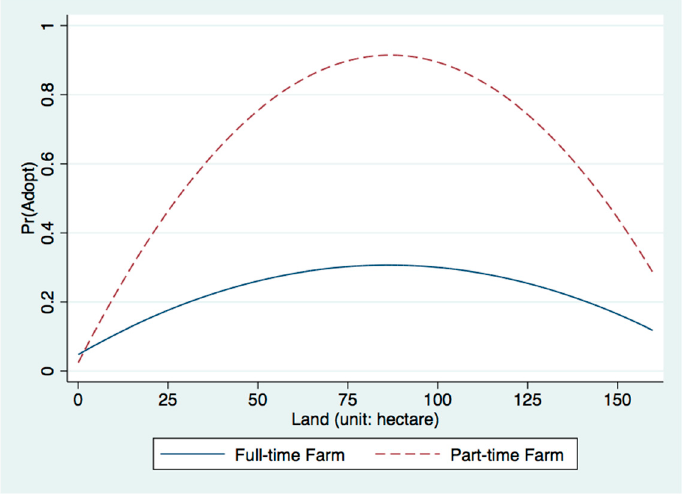
Figure 4. Predicted probability of full- and part- time farms with respect to land size.